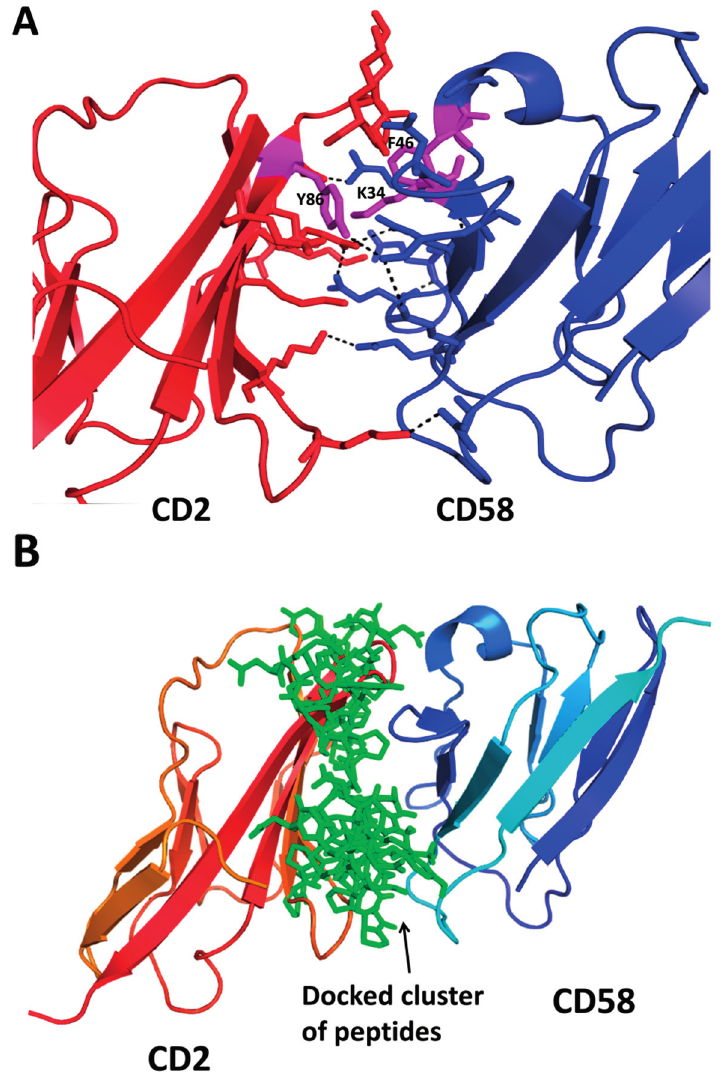
Figure 4. ( A ) Crystal structure of the complex of CD2 and CD58 (PDB ID: 1QA9) [217] adhesion domain involved in the recognition of T cells and antigen-presenting cells. Salt bridges and hydrogen bonds are shown by dashed lines. The hydrophobic hot spot is shown as magenta colored sticks. Note that, although the PPI surface is dominated with salt bridges and hydrogen bonds, the hydrophobic interaction between Tyr86, Phe46, and the Lys34 side chain sandwiched between the aromatic residues forms the hot spot; ( B ) A cluster of low-energy docked structures of a peptide bound to the CD58 protein adhesion domain [218–220]. PyMol (Schrodinger LLC) was used to generate the